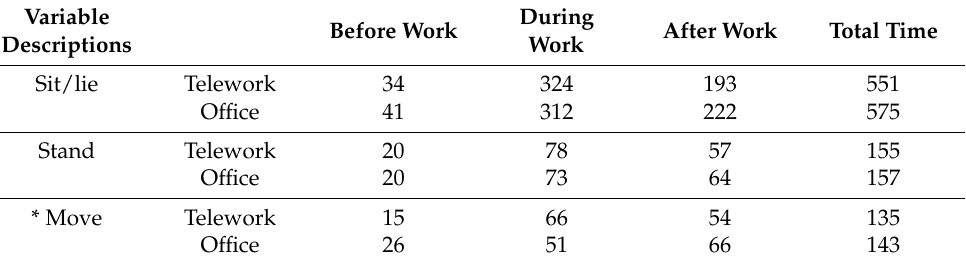
Table 4. Estimated geometrical means for time (min) spent in different physical behaviors before, during and after workhours on teleworking days and office days ( n =